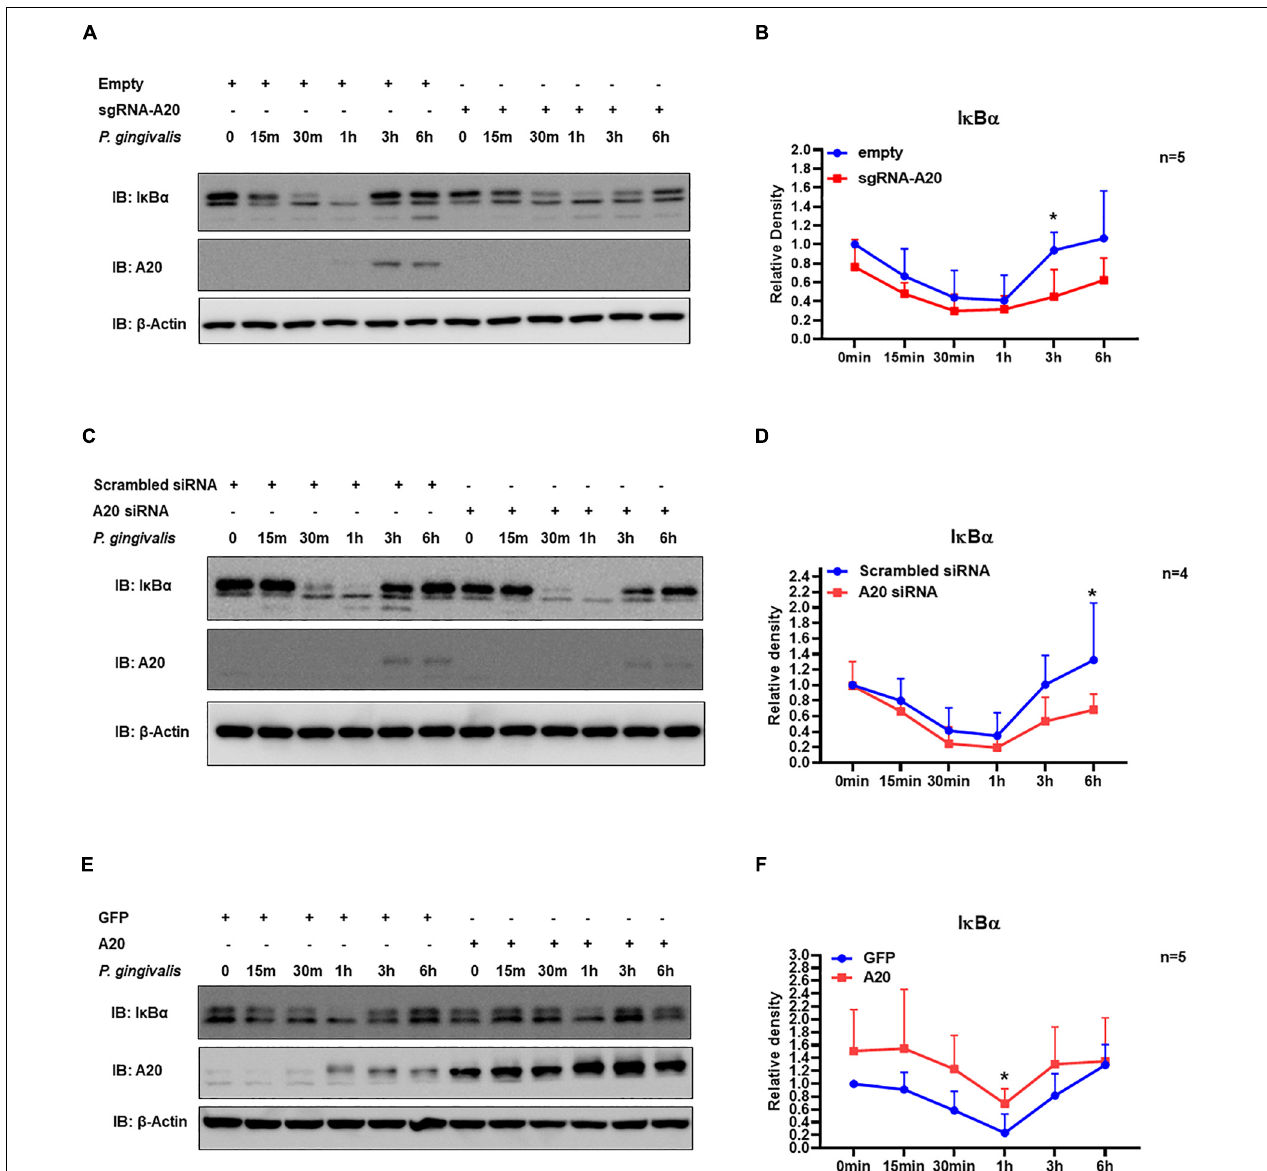
FIGURE 4 | A20 regulates TIGKs inflammatory response to P. gingivalis infection through NF-kB signaling. Western blots detecting I κ B α levels in TIGKs with altered A20 expression or control cells infected with P. gingivalis . Representative blots of I κ B α levels in A20 depleted TIGKs infected with P. gingivalis (A,C) Relative density of I κ B α levels from four or five independent experiments were plotted with mean and standard errors (B,D) . Representative blots of I κ B α levels (E) in A20 overexpressing TIGKs infected with P. gingivalis and relative density of I κ B α levels from five independent experiments as indicated were plotted with mean and standard errors (F) . Control or A20 expression altered TIGKs were infected with P. gingivalis (100 MOI) for the indicated time courses and the cells were harvested and lyzed and applied for protein assays with Western blots. Each experiment was performed independently, and representative blots were shown. Values are presented as mean and standard error. * P <